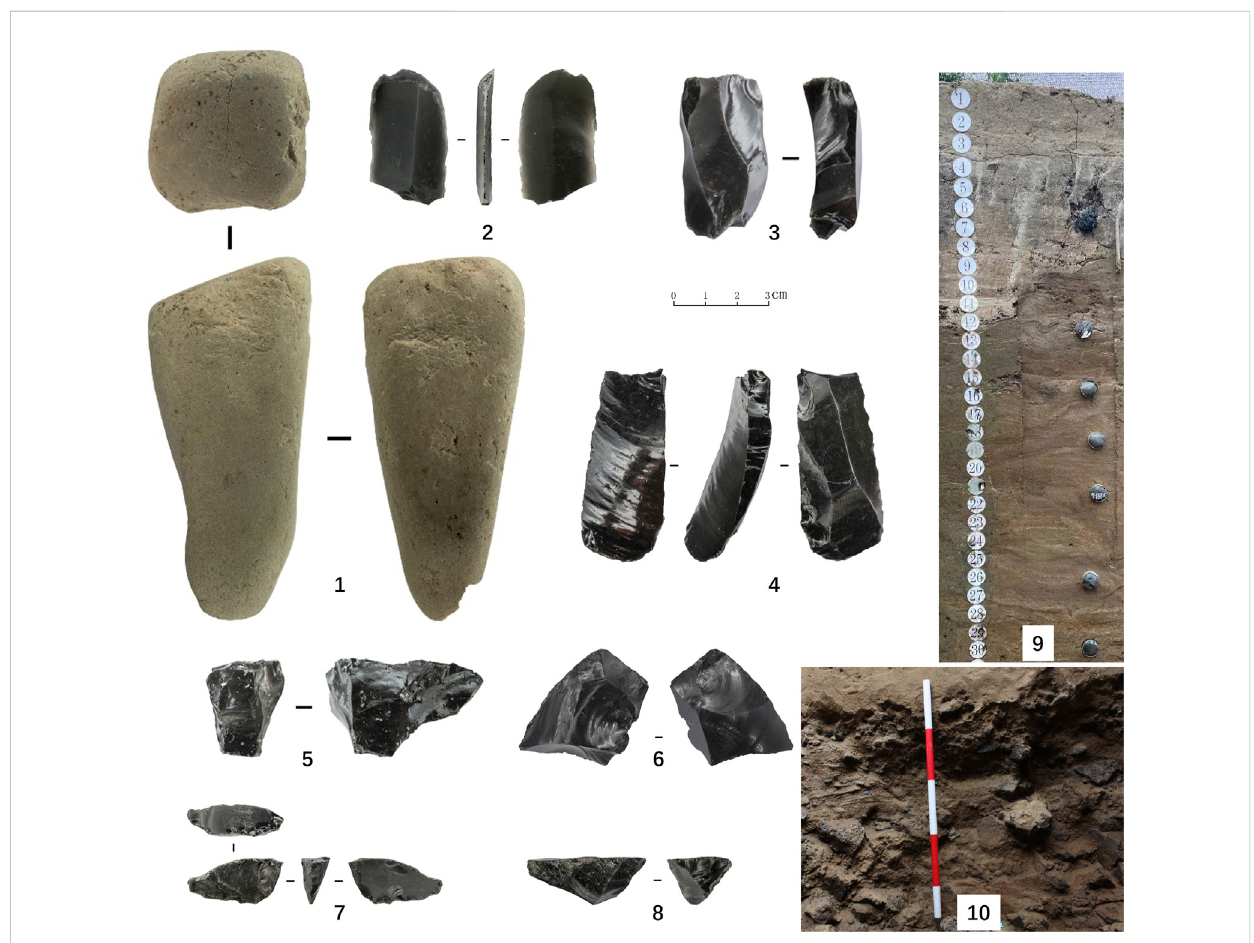
FIGURE 2 StoneartifactsfromtheDadongsite:1.Stonehammer,Layer5;2.Endscrapper,Layer5;3.Bladecore,Layer4;4.Burin,Layer5;5.Core,Layer4;6.Point, Layer 3; 7. Wedge-shapedmicrocore, Layer 3;8. Single-platform core, Layer 3; 9. Photo of Layers 1-6, note the vertical ice wedges fi lled with grayish-white sediment in the upper part of the pro fi le. The circular scale has a diameter of 5 cm; 10. Details of Layer 7, note the mixture of gravels and coarse